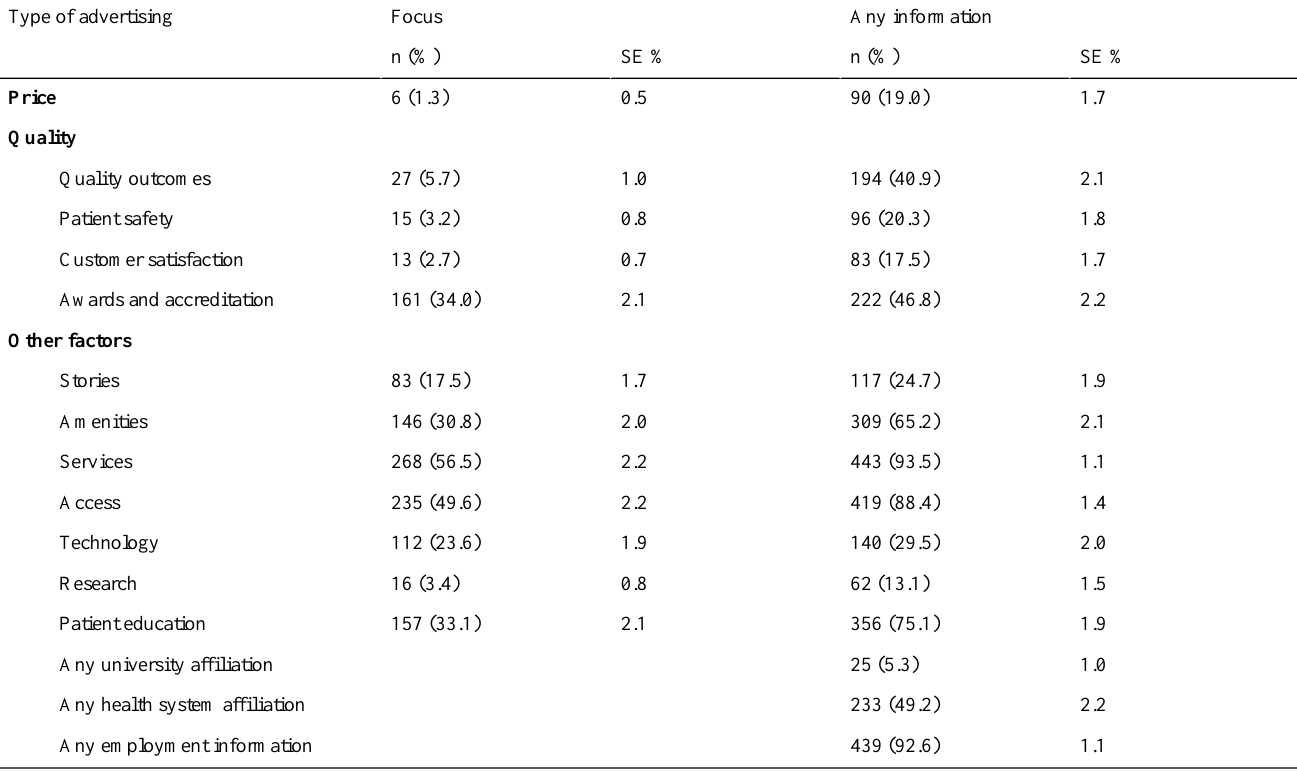
Table 3. Percent of US hospitals that use various types of website advertising